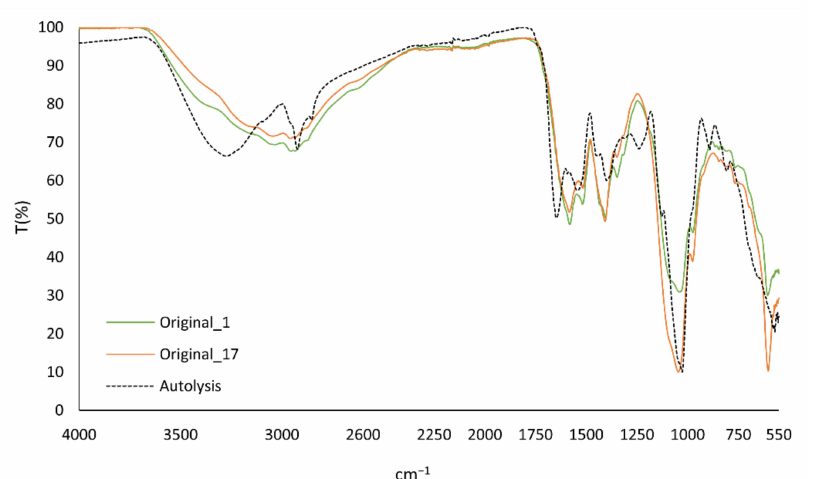
Figure 4. FT-IR spectra of iron–peptide complexes at a protein concentration of 1 g/L (Original_1) and 17 g/L (Original_17) versus autolysis supernatant (original peptide-rich substrate for complexation). Other changes are also visible in the from 1750 to 1400 cm − 1 range. Two strong peaks have appeared at 1580 and 1410 cm − 1 , while in the un-complexed supernatant, similar bands are found at 1650 and 1390 cm − 1 , with lower intensity in the latter. These shifts may be related to the stretching vibration of Fe-COO bonds, asymmetrically and symmetrically, respectively, as reported previously [34], further supporting the presence of iron–peptide